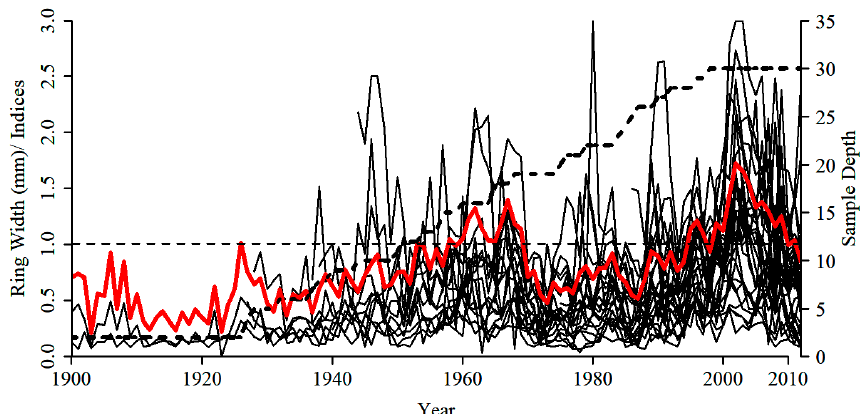
Figure 5. Individual tree-ring width (black line) and site ring width index chronology (red line) of Mountain Hemlock along the study site transect. Sample depth is represented in black dotted line.